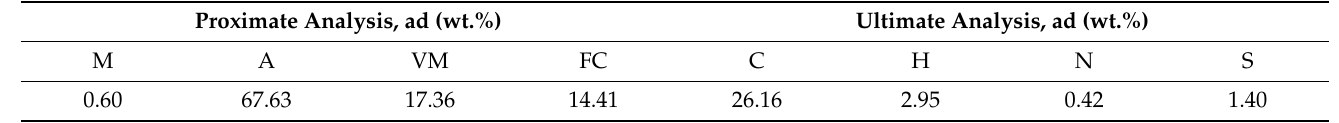
Table 1. Proximate and ultimate analyses of the kaolinite-based high ash slime (KAS).